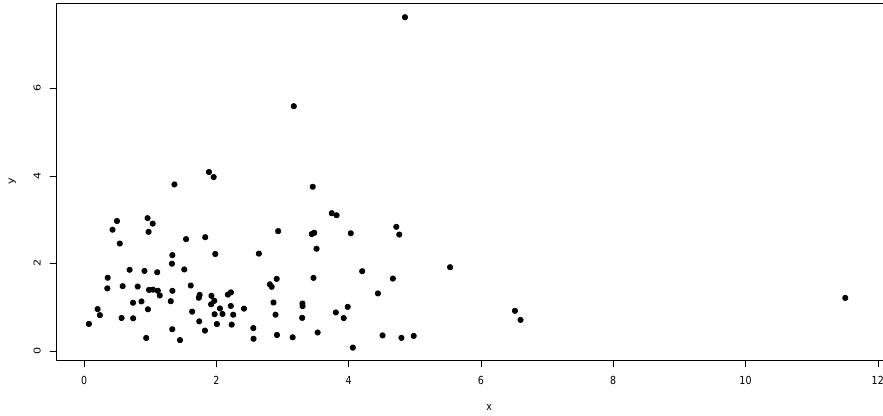
Scatterplots and marginal density plots are shown for the first data set based on the bivariate KW-type model in Equation (1).